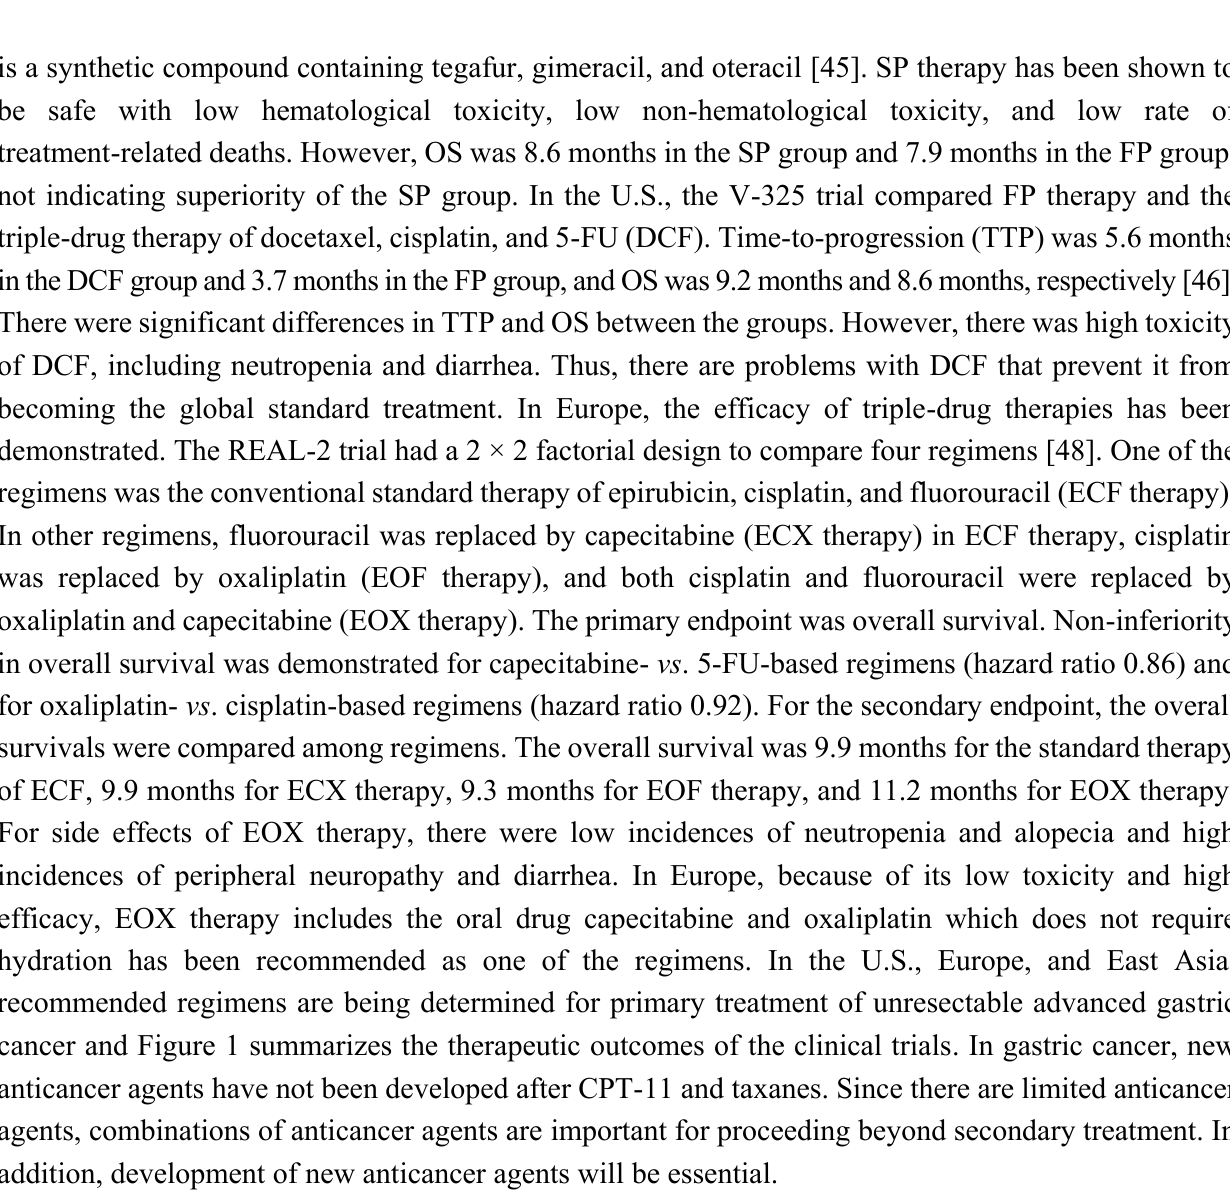
Figure 1. Median survival time of phase III trials of chemotherapy for unresectable gastric Figure 1 Median survival time of phase III trials of unresectabale gastric cancer were summarized.